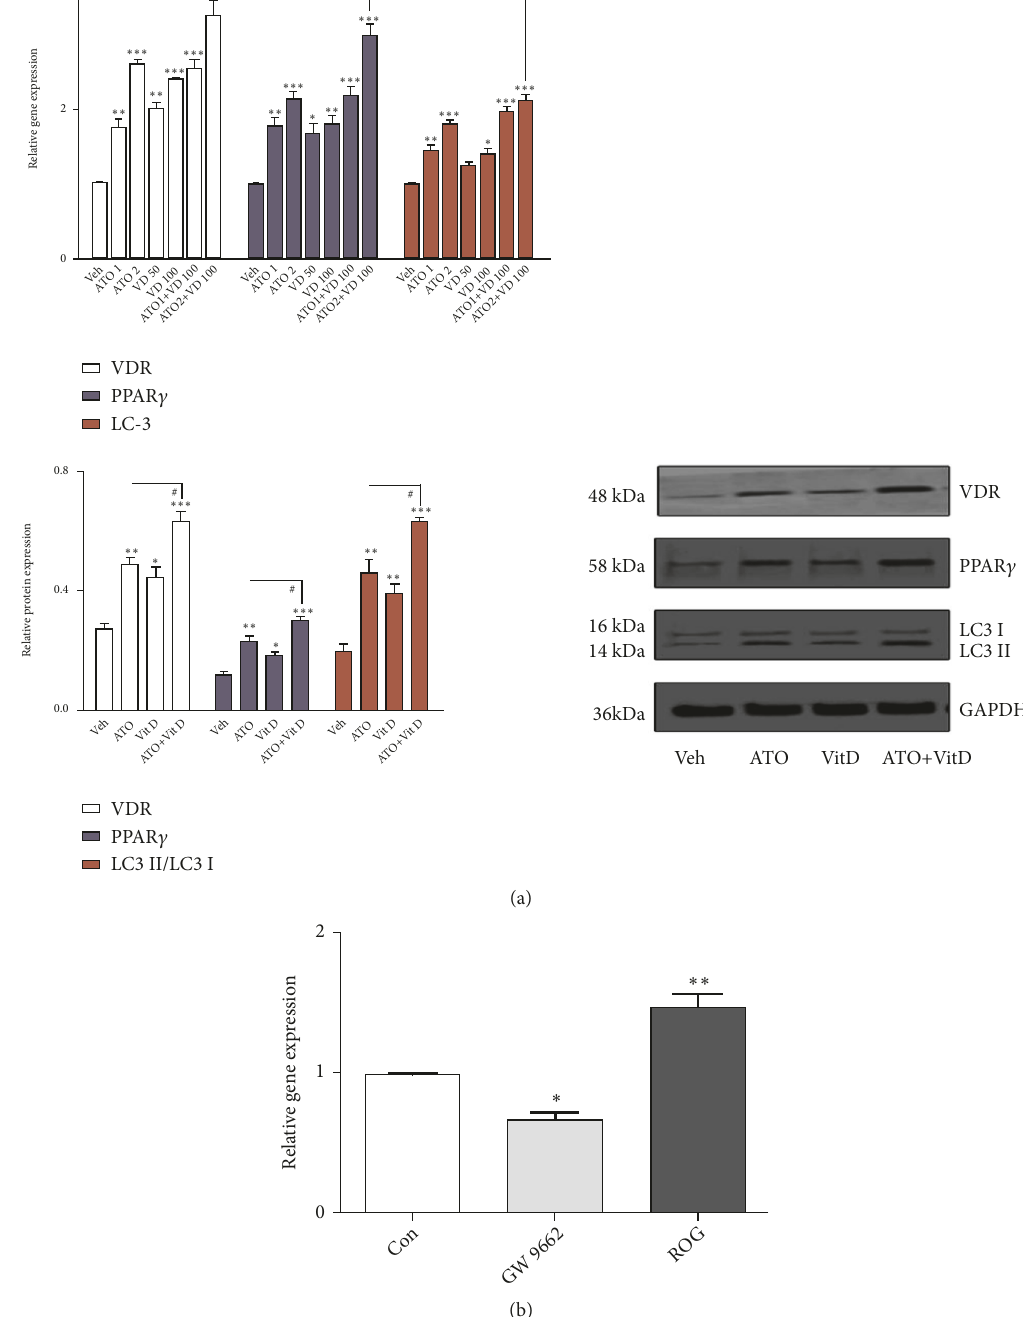
Figure 3: Combined effect of arsenic trioxide (ATO) and Vitamin D (Vit D) on the Vitamin D receptor (VDR)-PPAR- 𝛾 autophagy functional module . (a) Synergic upregulation of VDR, PPAR- 𝛾 , and LC-3 in rheumatoid arthritis (RA) fibroblast-like synoviocytes (FLS) after administration of ATO (2 𝜇 M) and Vit D (50 and100nM) alone or in combination compared with the vehicle ( n =3; ∗ p < 0.05; ∗∗ p < 0.01; ∗ ∗ ∗ p < 0.001). (b) Real-time PCR showed a significant decrease in the expression of VDR mRNA in RA FLS after treatment with GW9662, an antagonist of PPAR- 𝛾 . On the other hand, treatment with rosiglitazone (ROG) significantly upregulated VDR mRNA expression ( n =3, ∗ p < 0.05; ∗∗ p < 0.01 versus RA FLS treated with the medium alone